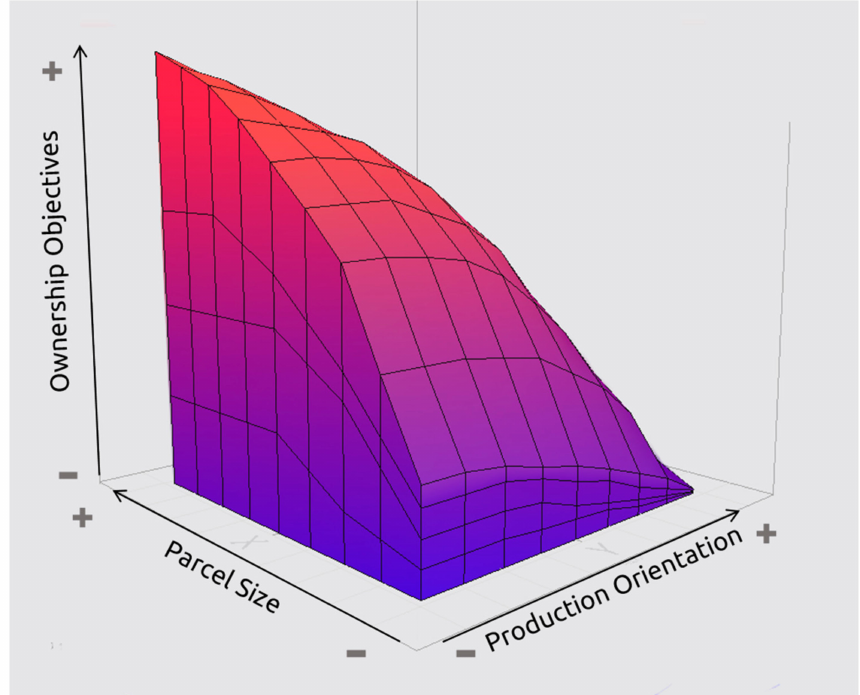
Figure 3. Illustration of landowner characteristics influencing landowner participation in MSM. Areas on the diagram in red represent a combination of characteristics conducive for adopting MSM, while areas in purple represent a combination of characteristics that dissuade practicing MSM. Plus signs indicate an increase in a landowners production orientation, parcel size, and number of ownership objectives. Minus signs indicate a decrease in landowner production orientation, parcel size, and number of ownership